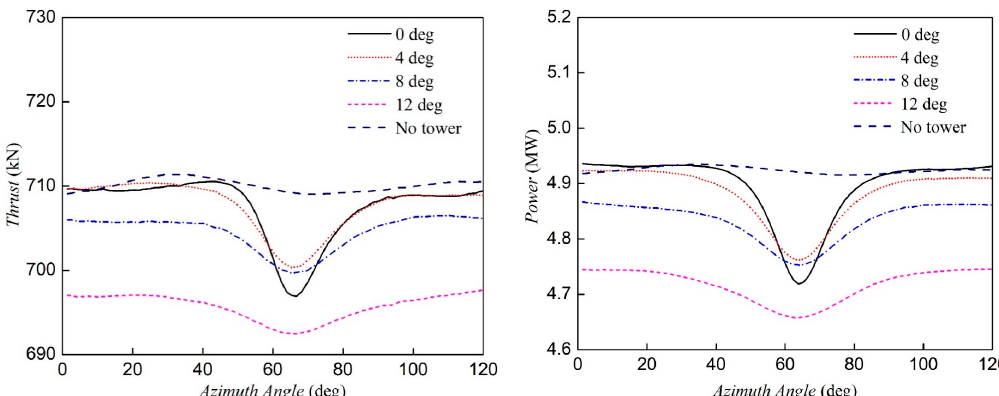
Figure 10. Comparison of thrust and power at different nacelle tilt angles (partial enlargement).